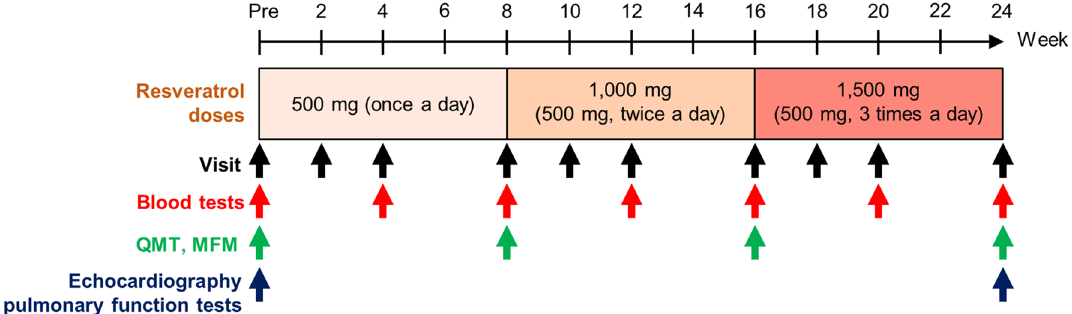
Figure 1. Protocol for resveratrol administration. Daily doses of resveratrol are shown, and visits along with blood and physical examinations are indicated by arrows.